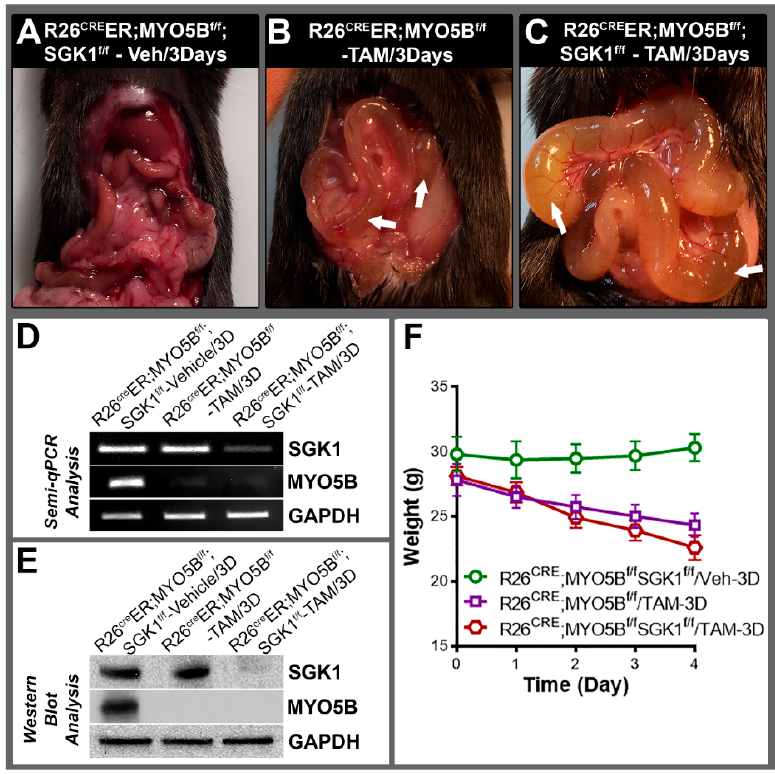
Figure 10. cMYO5B-SGK1 DKO mice display more severe diarrhea vs. cMYO5B KO